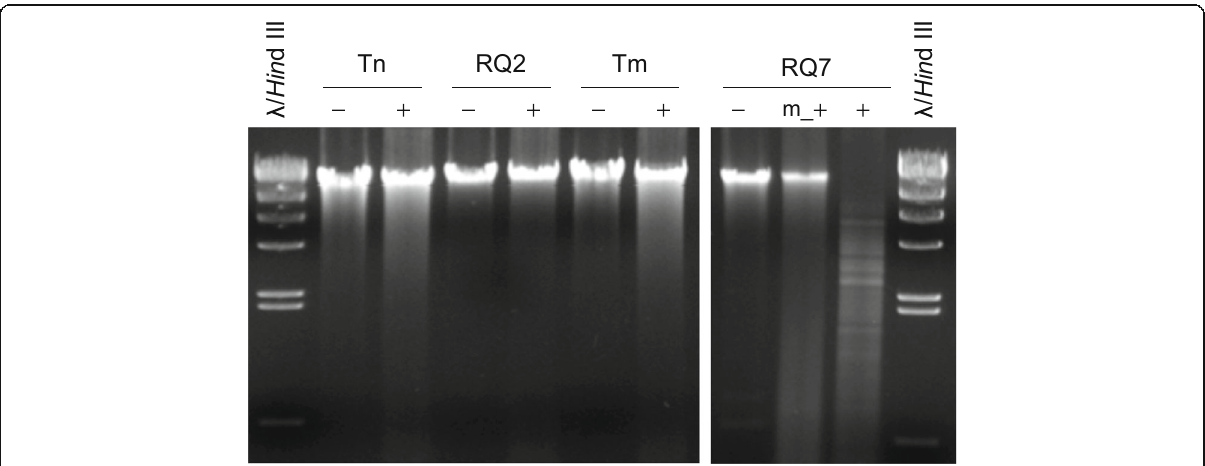
Fig. 8 Digestion of the genomic DNA of T. neapolitana DSM 4359 (Tn), T. sp. strain RQ2 (RQ2), T. maritima MSB8 (Tm), and T. sp. strain RQ7 (RQ7) with R.TneDI. -, negative control, no R.TneDI; +, digestion with R.TneDI; m_+, DNA was treated with M.TneDI prior to being digested by R.TneDI